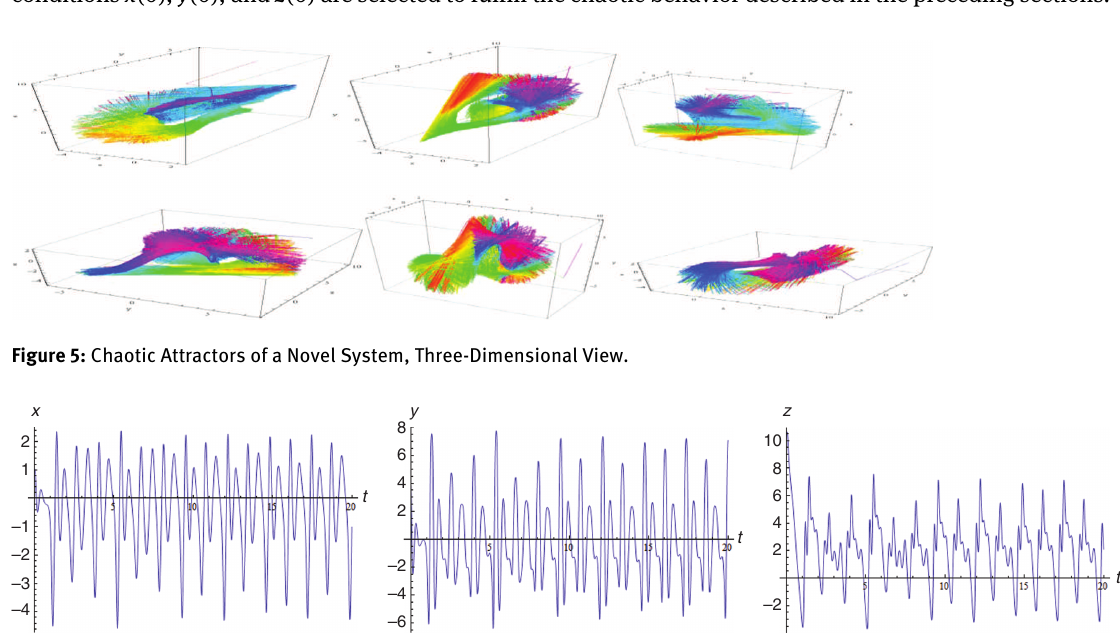
Figure 6: Time versus ( x , y , z ) of the Novel Chaotic